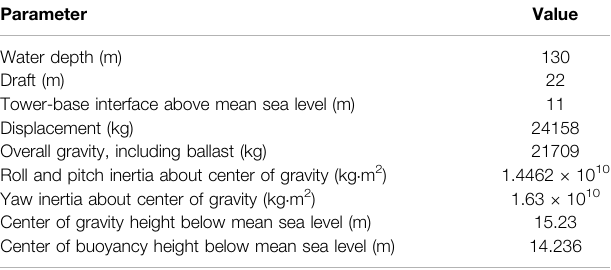
TABLE 2 | The main properties for the 10-MW OO-Star wind fl oater. Parameter